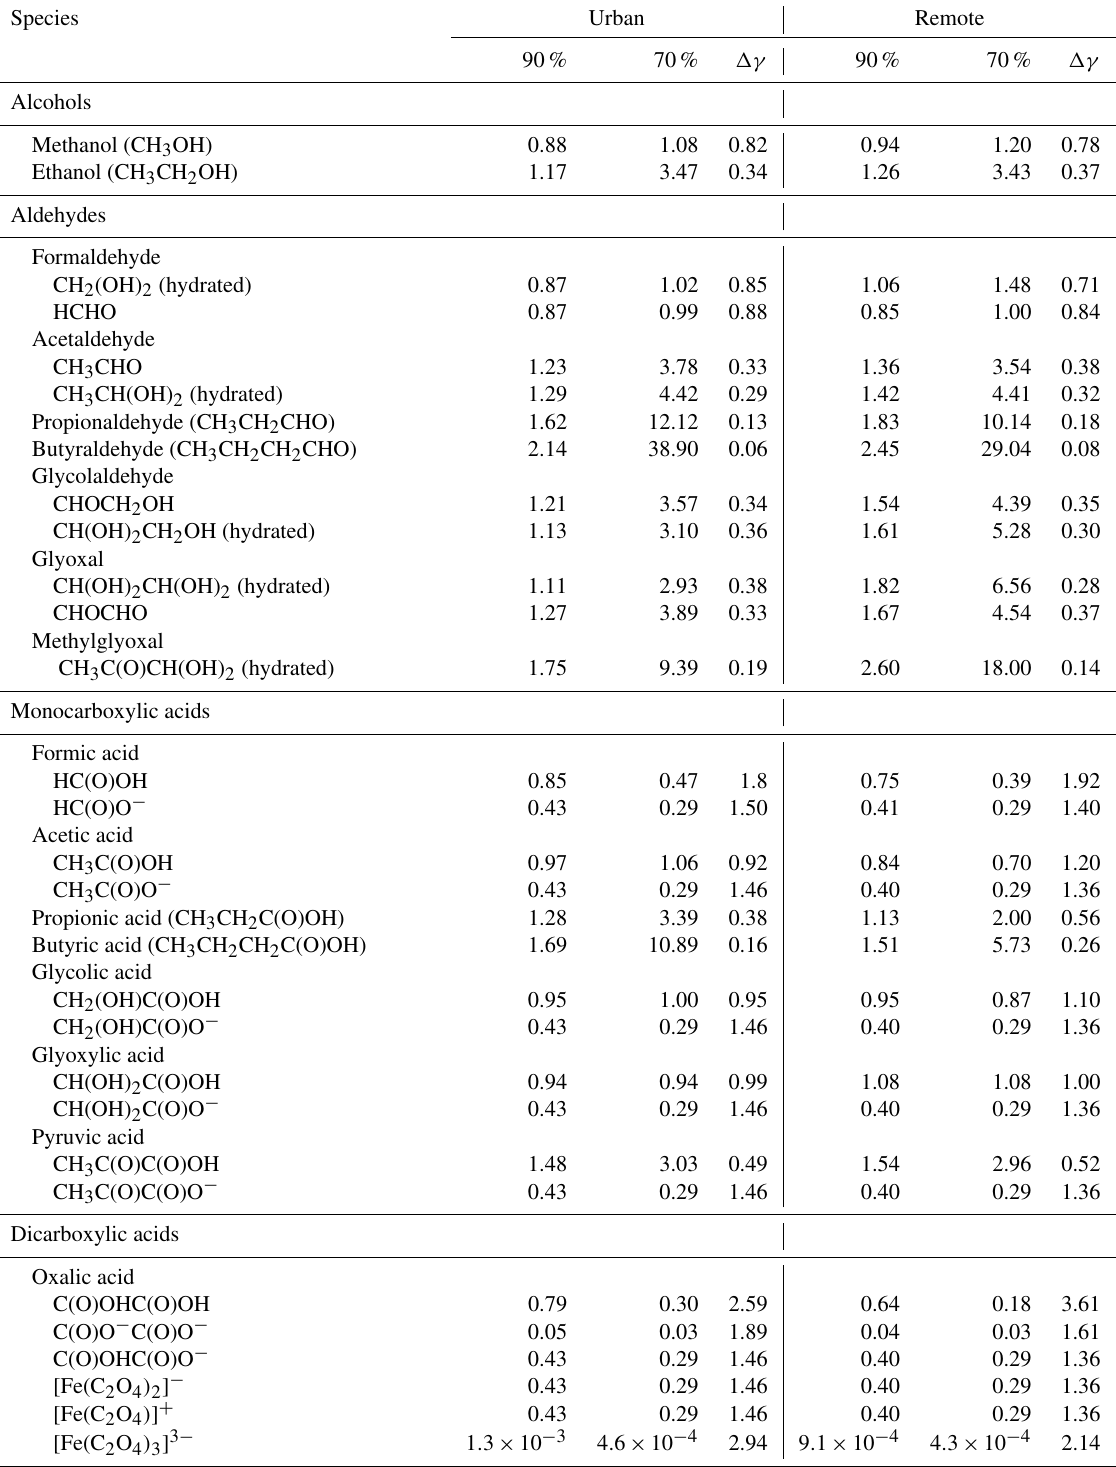
Table 4. Predicted activity coefficients of selected organic compounds in deliquesced particles for the 90% / 70%-NIDR and 90% / 70%- NIDU simulations at 29h. (cid:49)γ represents the ratio of the predicted activity coefficients of the 90% case and the 70% case, respectively. Species Urban